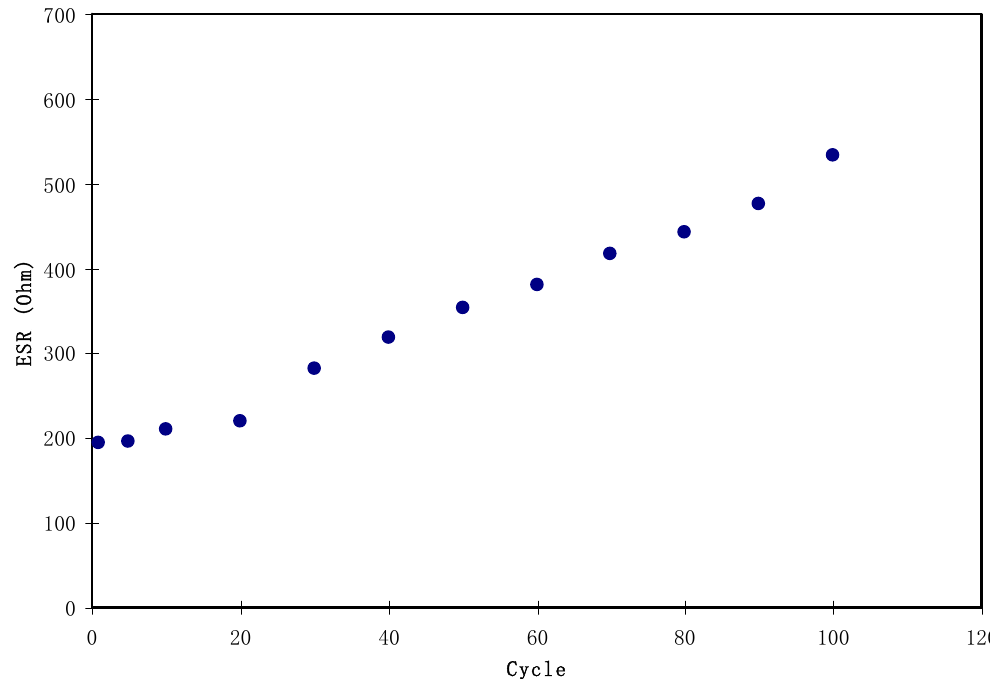
Figure 13. The pattern of equivalent series resistance of the EDLC for 100 cycles.